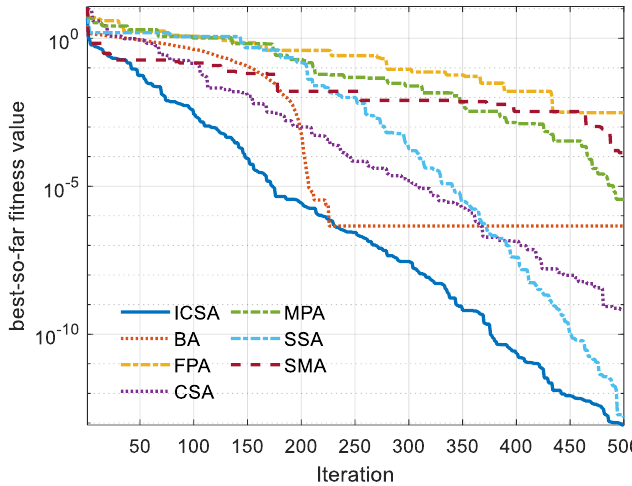
Figure 4. Convergence curve for F3.